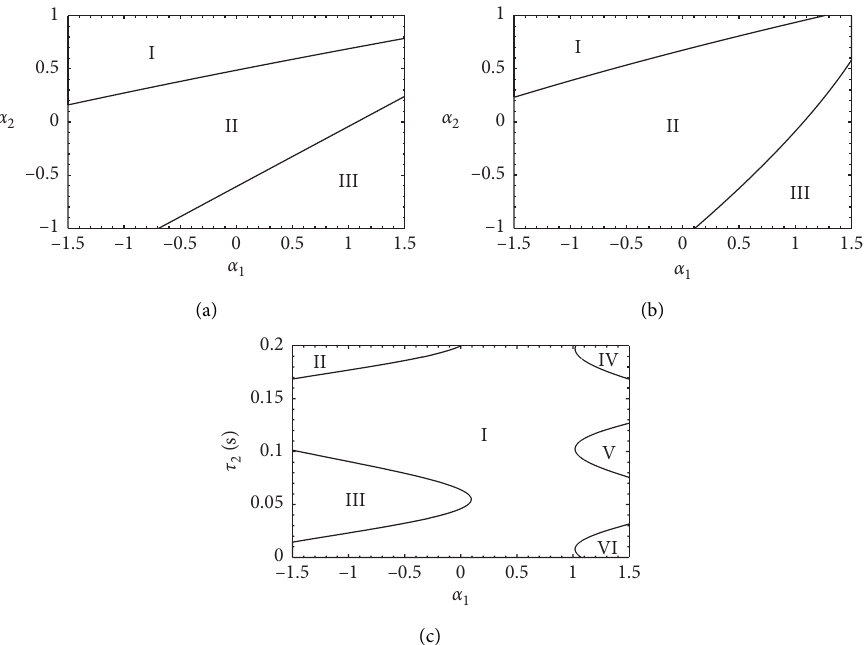
Figure 5: Stability charts of the coupled system. (a) τ